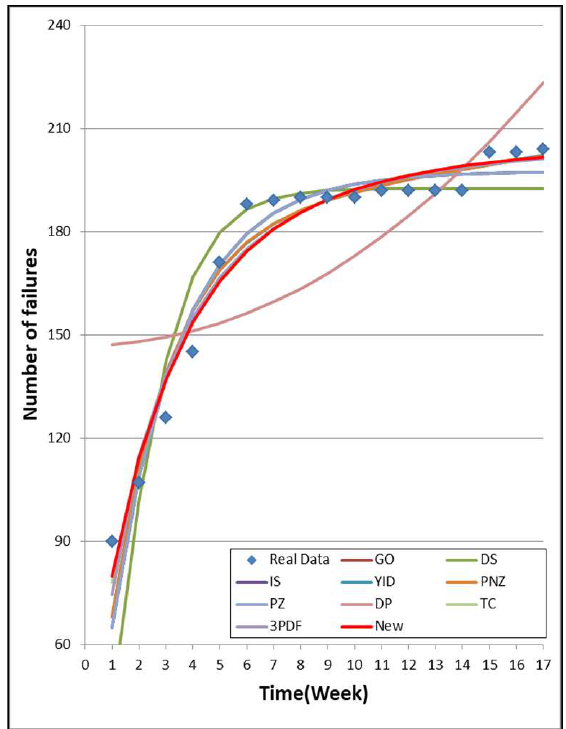
Figure 3. Mean value function of the ten models for DS2.